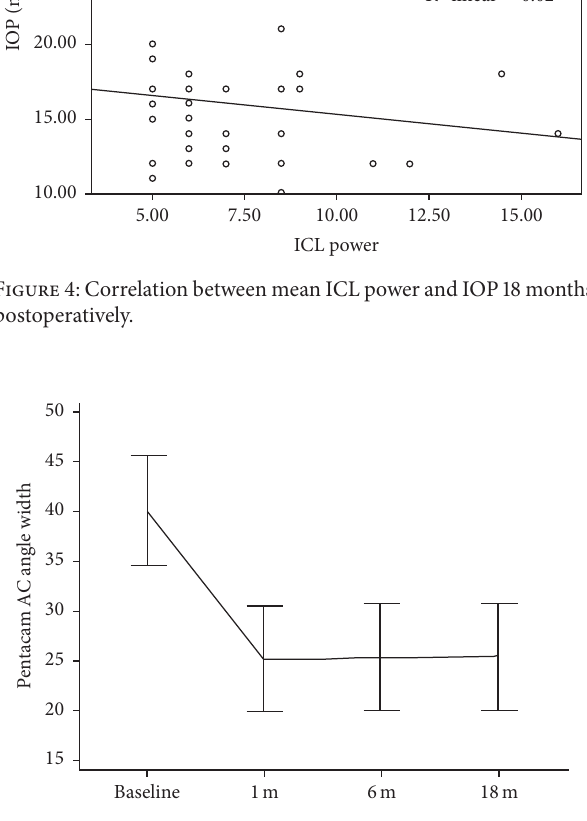
Figure 5: Mean Pentacam AC angle width at baseline and 1, 6, and 18 months postoperatively.